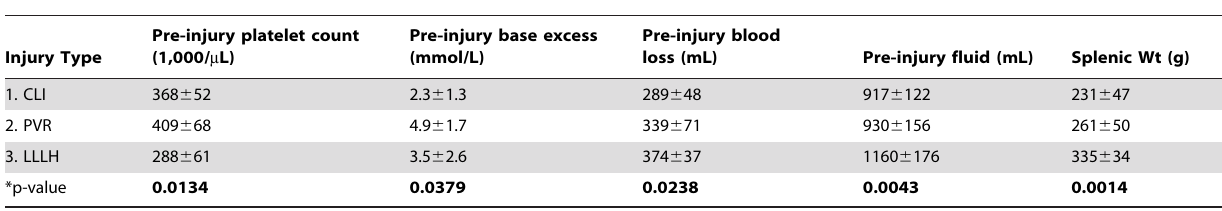
Table 2. Pre-injury parameters not equivalent among the three injury